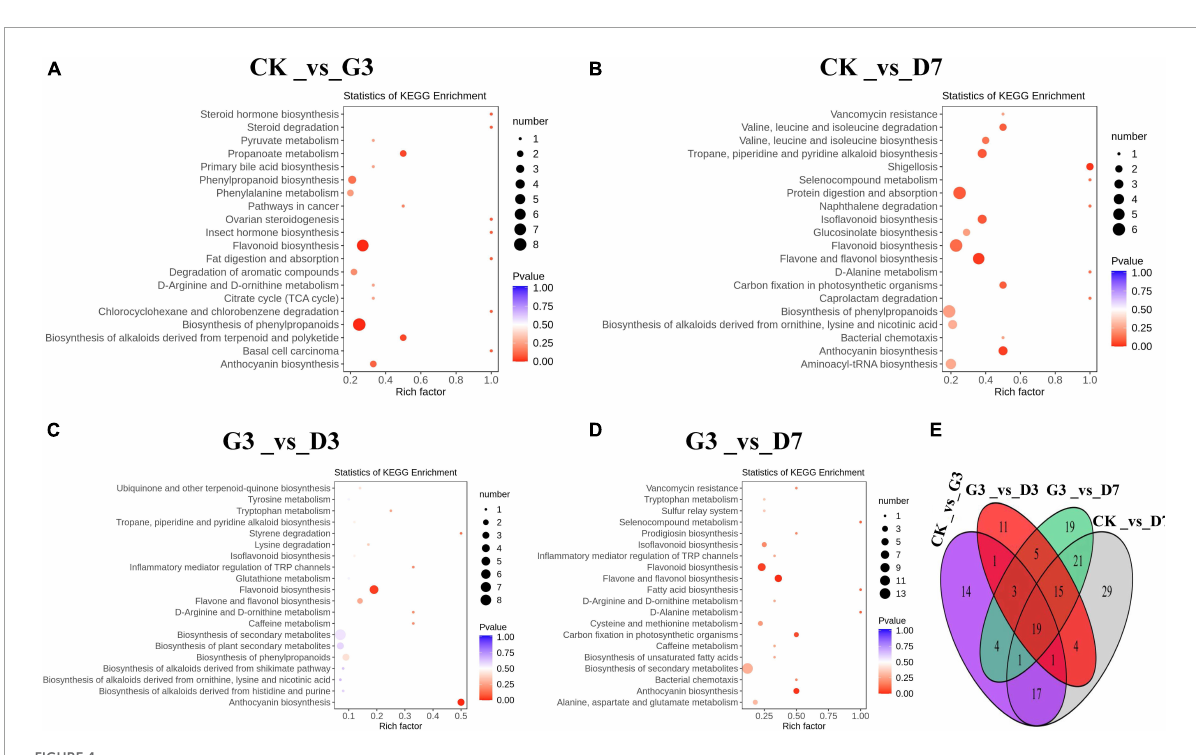
FIGURE4 Identification and functional characterization of the differentially accumulated metabolites (DAMs) in the different treatments. KEGG enrichment analysis of the DAMs in (A) CK_vs_G3, (B) CK_vs_D7, (C) G3_vs_D3, and (D) G3_vs_D7. (E) Venn figure showing the shared and specific metabolites among the four